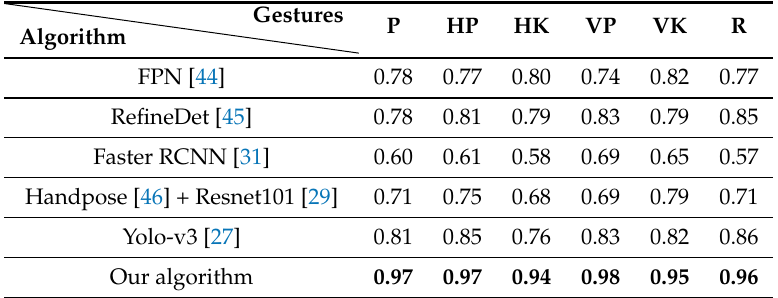
Table 6. Recall Rate of different algorithm when Precision is 0.98.(trained and tested by our